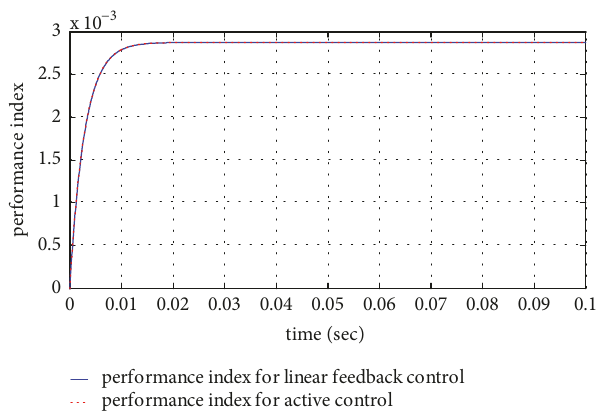
Figure 7: Performance index for linear feedback control and active control.